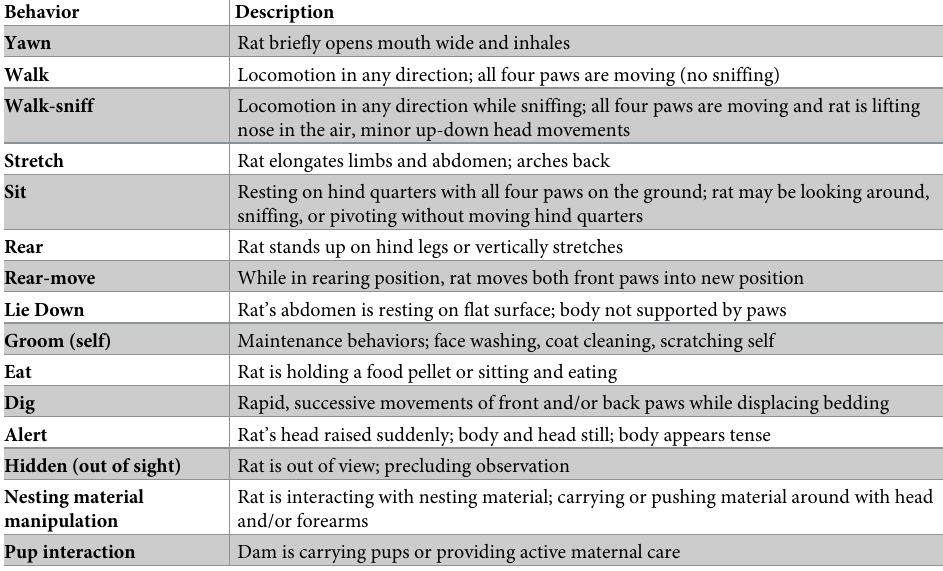
Table 2. Ethogram used to score anticipatory